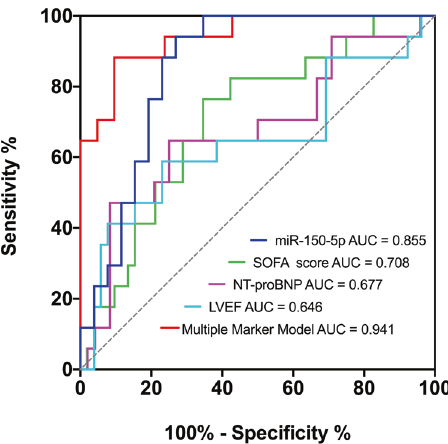
Fig. 4 ROC curves for comparing the ability of exosomal miR-150- 5p, SOFA score, NT-pro BNP, LVEF, and Multiple Marker Model to discriminate SIC patients from non-SIC. Non-SIC (D1) n = 30 biologically independent samples; SIC (D1) n = 20 biologically independent samples (validation cohort).